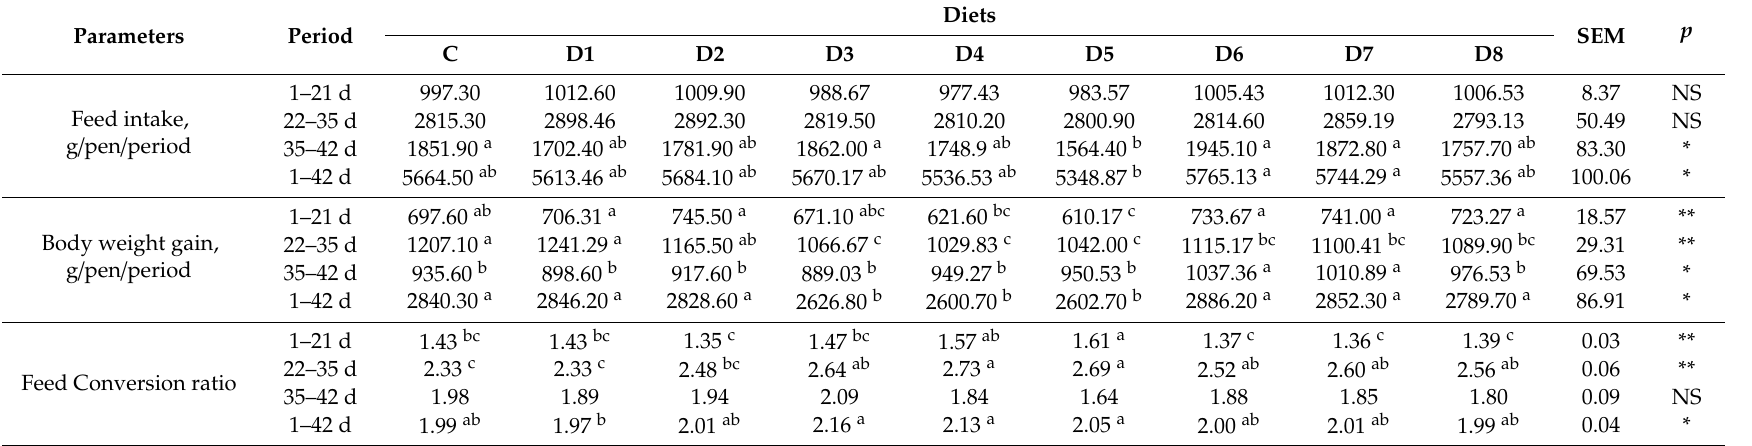
Table 3. Growth performance of Ross 308 broilers fed diets containing di ff erent levels of L-carnitine and lysine-methionine from day 1 to day 42 of age.